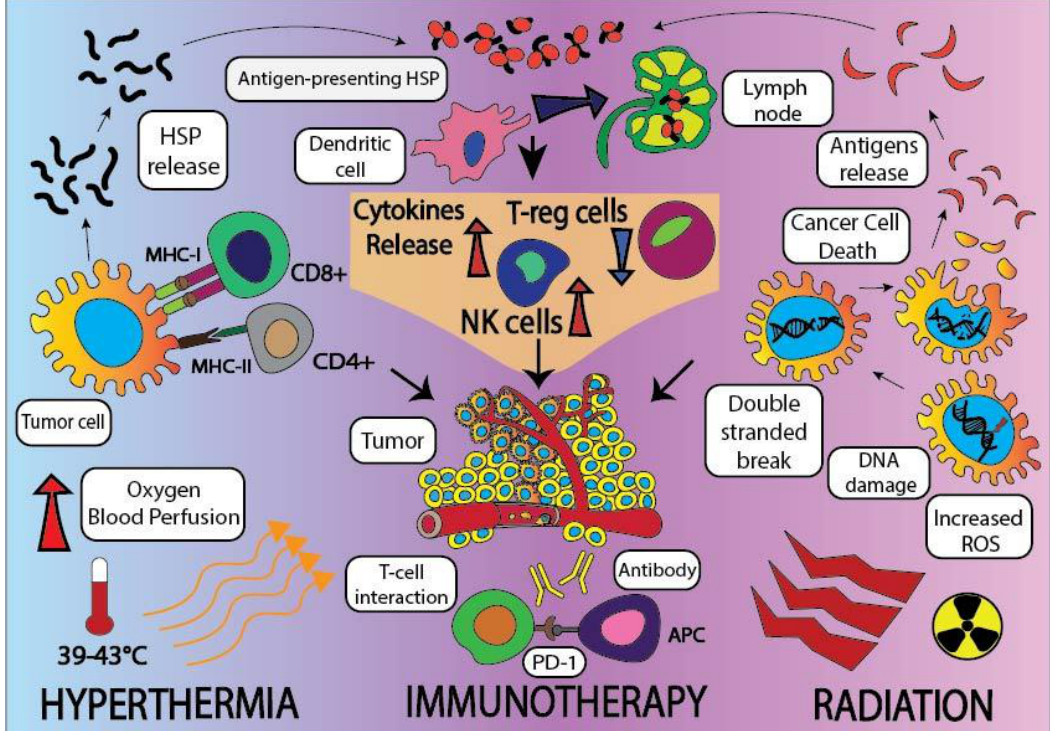
Figure 2. Schematic representation of tripartite modality combining hyperthermia with radiation and immunotherapy and their combined additive effect against cancer cells in the immunosuppressive tumor microenvironment (TME). NK cells: Natural Killer Cells.